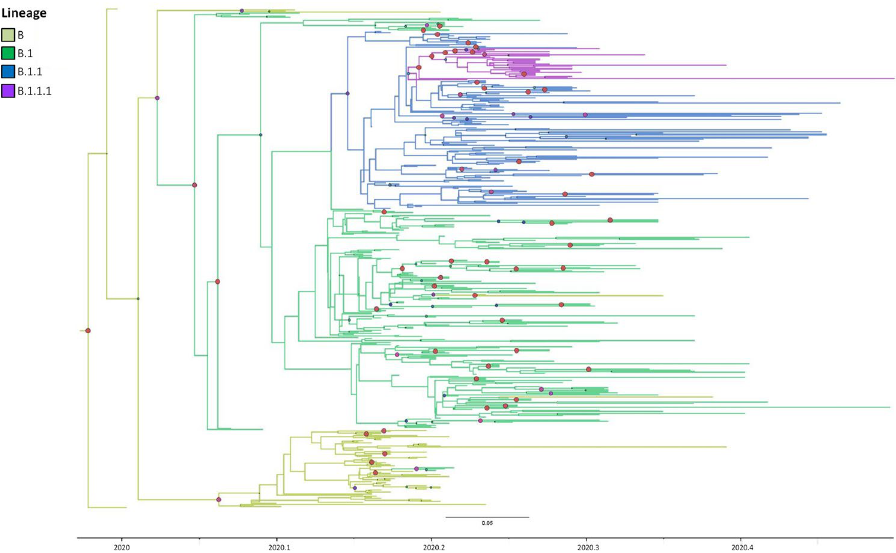
Figure 2. SARS-CoV-2 Bayesian phylogeographic tree of 479 strains. Large red and purple circles indicate highest posterior probability ranging from 1 to 0.9. The branches are coloured based on the most probable lineage of the descendent